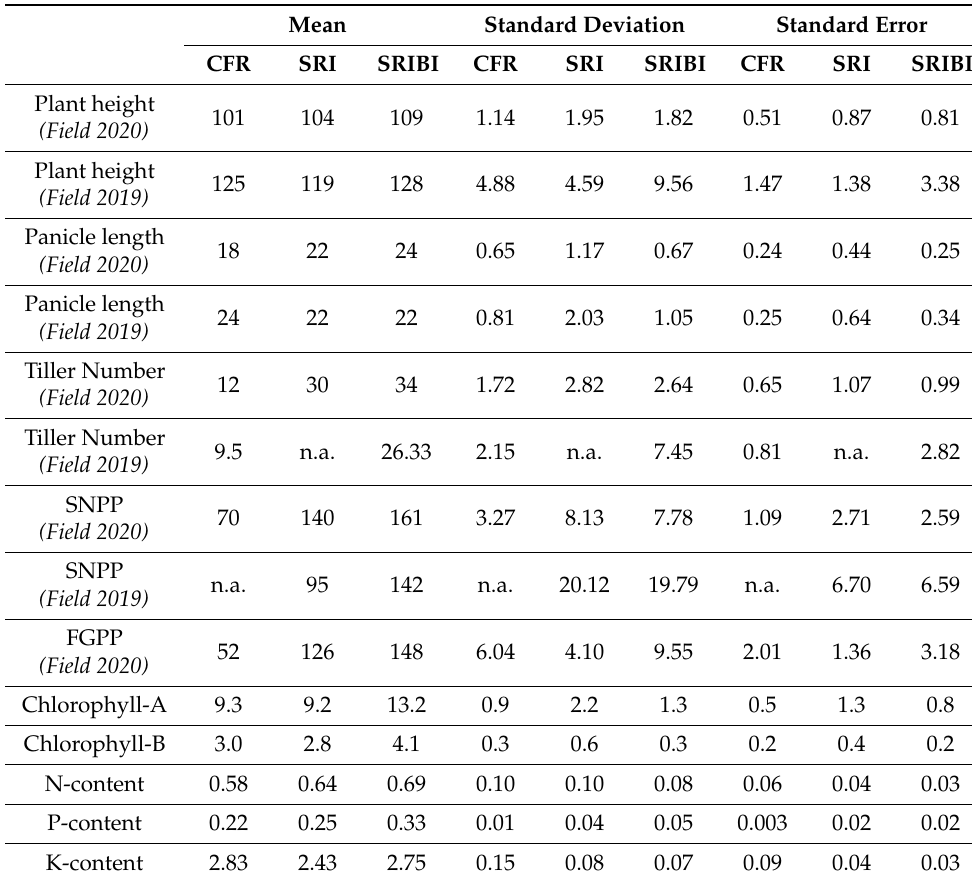
Table A1. Different Statistical Data about the Different Measured